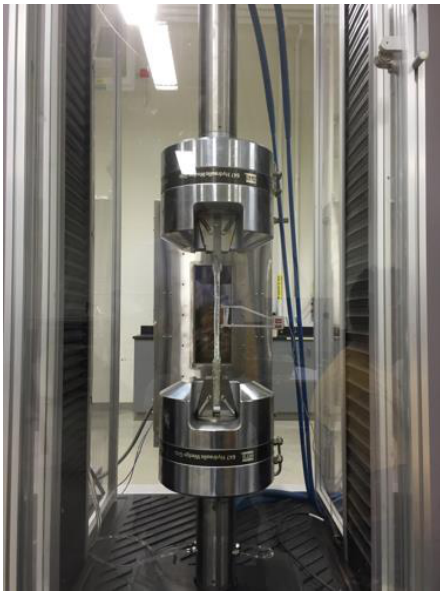
Figure 3. Clamping grips. Figure 3. Clamping